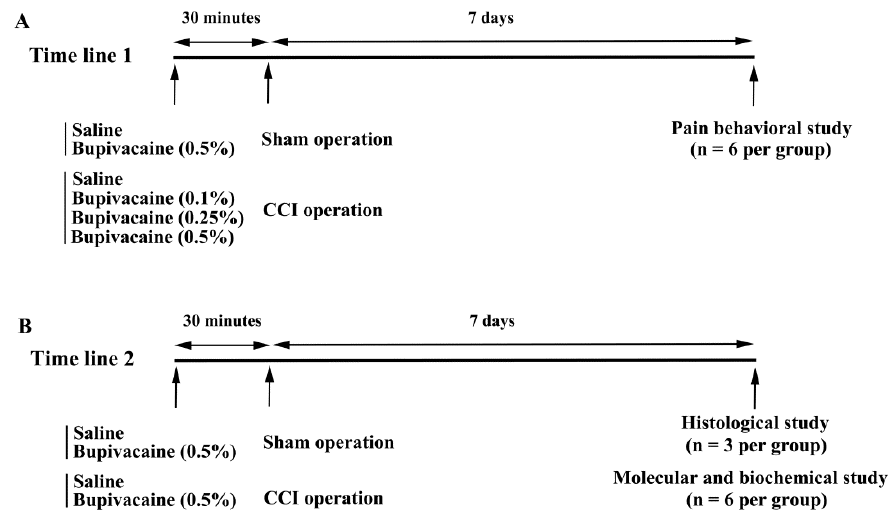
Figure 5. Time lines for experimental procedures. ( A ) Pain behavioral study consisted of six groups, including two groups of sham operation and four groups of CCI operation, indicated as time line 1.